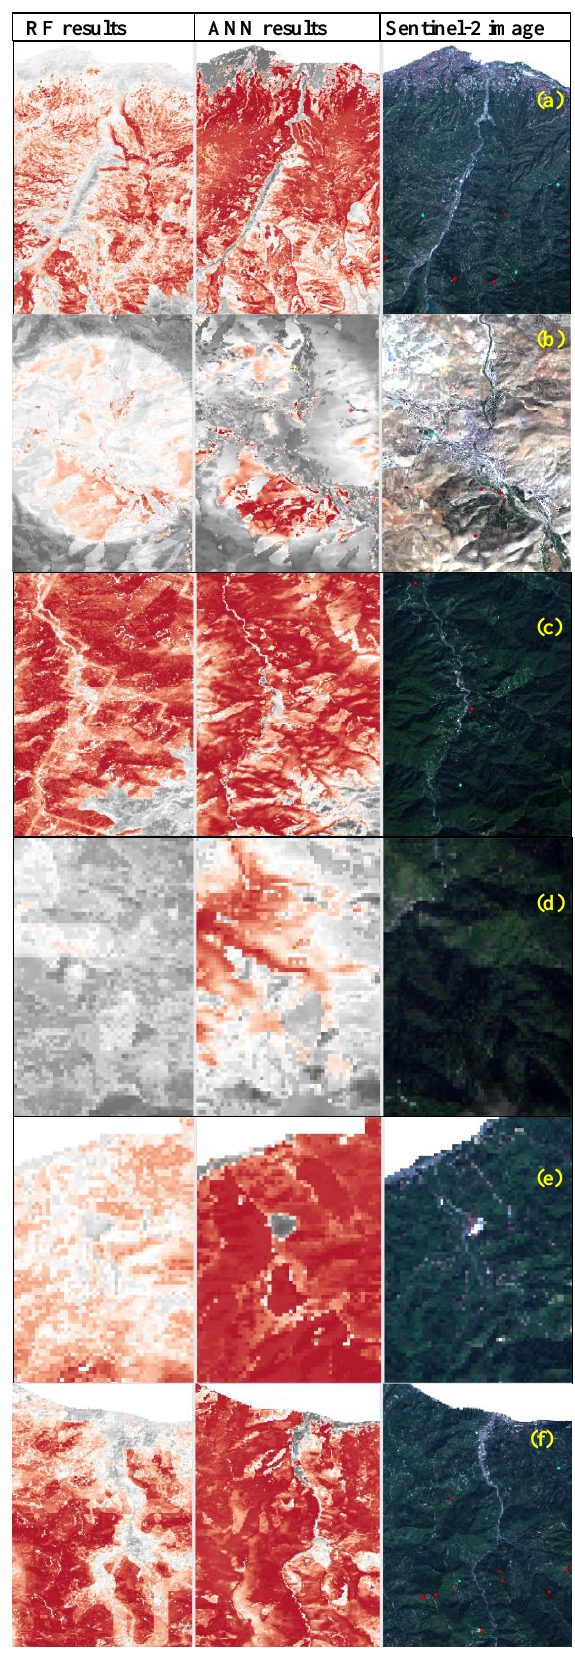
Figure 7. Local details of the maps shown in Figure 6. (a) Trabzon city (b) Bayburt city; (c) Hemşin, Rize; (d) Kızılot, Gümüşhane; (e) Isıkli Village, Ardeşen; (f) Sürmene,